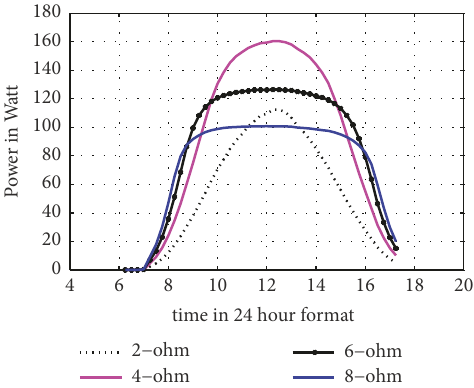
Figure 17: Hourly variation in power output of Kyocera 200GT PV module for different electric load under weather condition of January 1 st .